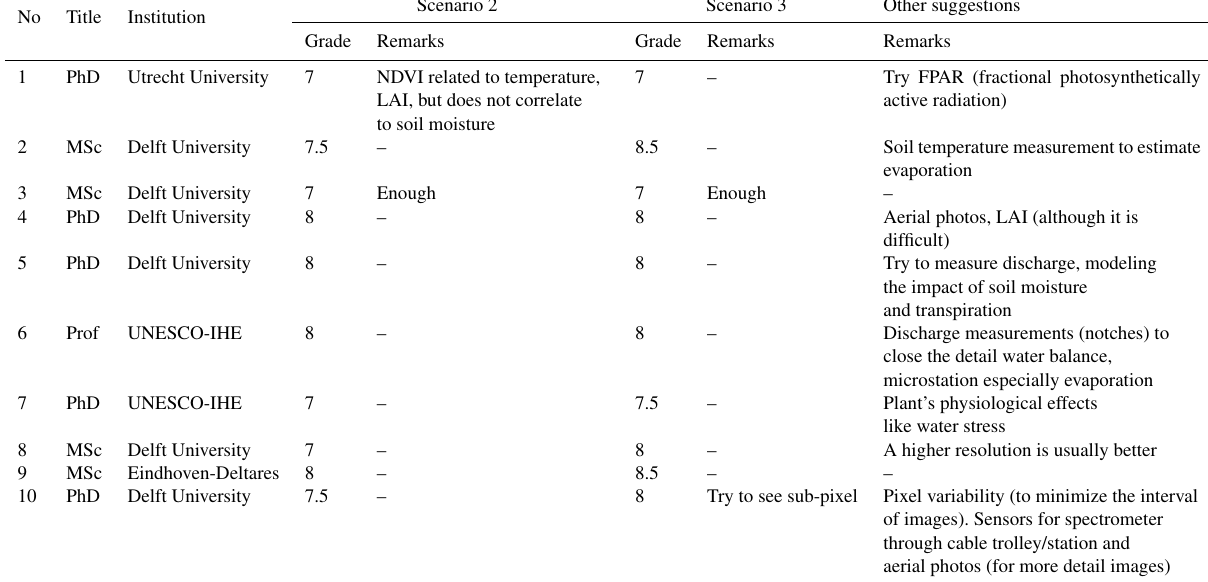
Table B2. Kenya case: the experts’